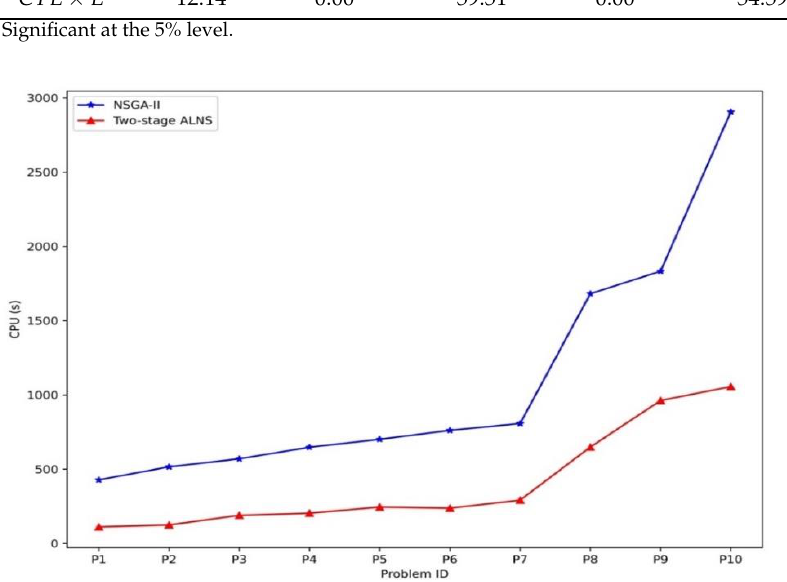
Figure 4. The two-stage ALNS method outperforms the NSGA-II method in terms of computational effort. Table 19. Multiple comparison of part-skill score in each cell-cohesion requirement